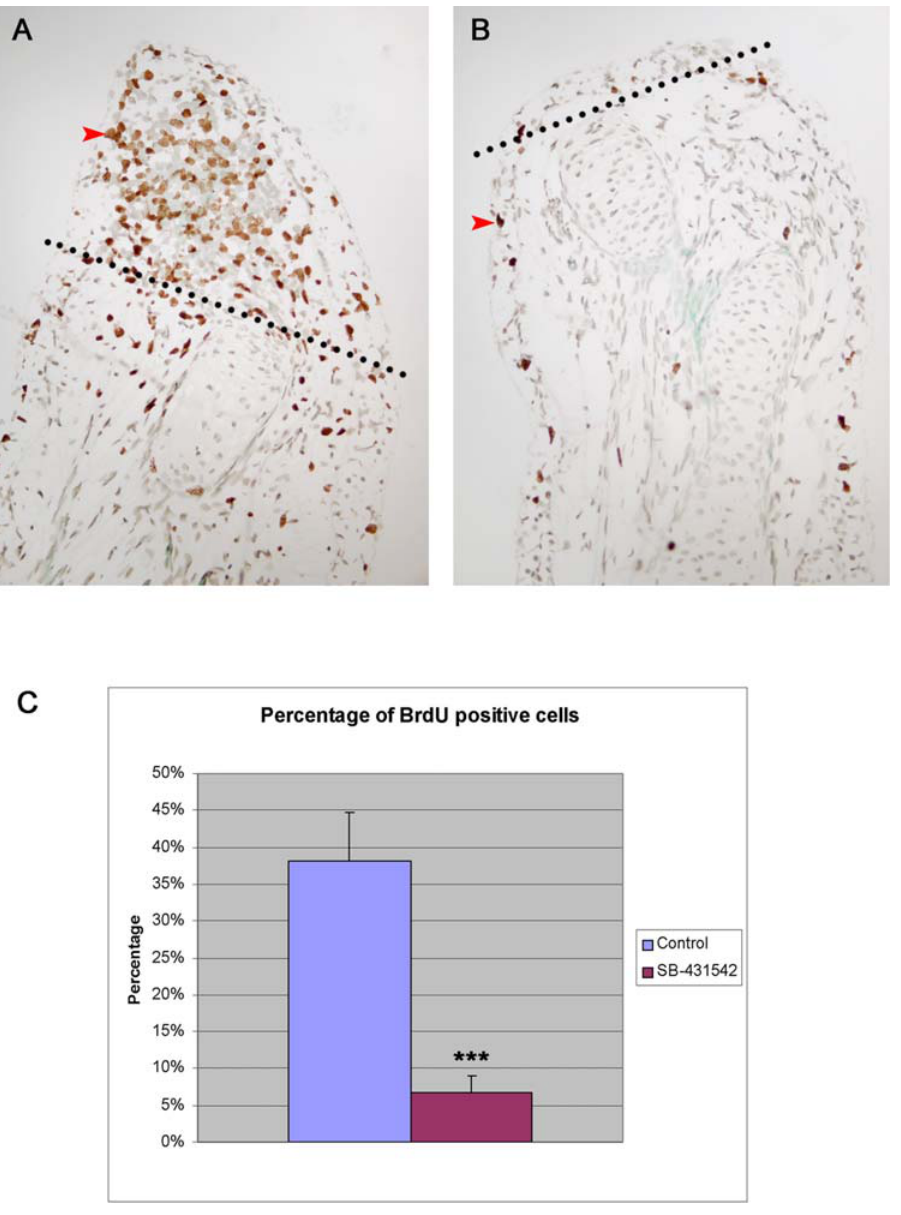
Figure 6. Inhibition of cellular proliferation in regenerating limbs treated with SB-431542. A) Control regenerating limb treated with DMSO and assessed for BrdU incorporation at 7 days post-amputation (medium bud stage). Red arrowhead marks a cell positive for BrdU. Note the accumulation of BrdU-positive cells in the regenerating blastema. Cells positive for BrdU are also found (at a lower frequency) in the epidermis of the non-regenerating part of the limb. B) SB-431542 treated limb assessed for BrdU incorporation 7 days post-amputation. No accumulation of BrdU- positive cells at the tip of the limb is observed. Only a few positive cells are found mostly in the epidermis of the limb (red arrowhead). Dotted lines in panels A and B represent the level of amputation. C) Graph comparing percentage of BrdU-positive cells in the regenerating blastema of control limbs (n=3 animals) and in SB-431542 treated limbs (n=3 animals). A statistically significant difference in the percentage of BrdU positive cells between control (38% 6 6.2%) and SB-431542 treated limbs (7% 6 2.1%) was observed (*** p ,